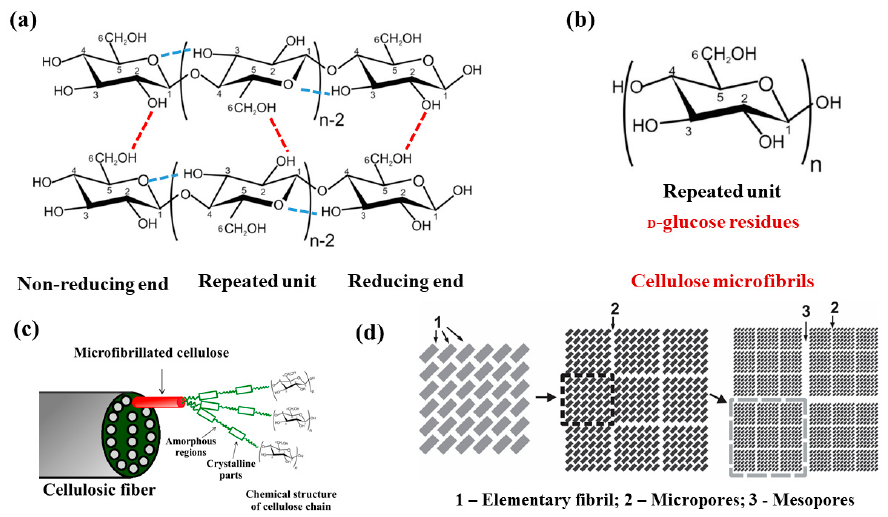
Figure 1. Chemical structure of cellulose representing reducing and non-reducing ends ( a ); D-glu- cose residues ( b ), the structure of cellulose macro fi brils ( c ), and variant cross section of macro fi brils consisting of aggregates micro fi brils, each containing four elementary fi brils ( d ). Adapted from